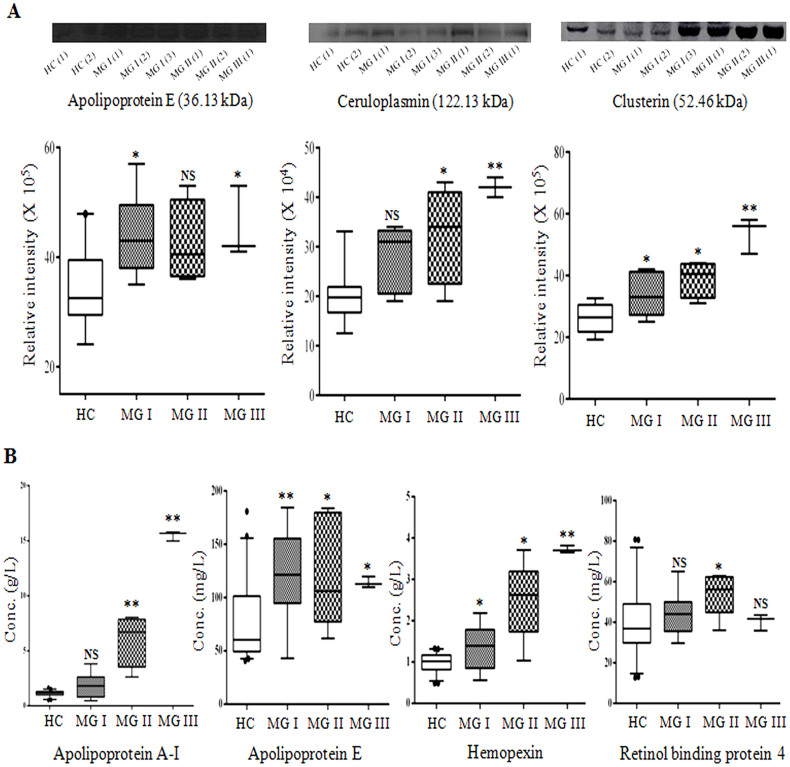
Immunoassay-based validation of selected differentially expressed proteins.(A) Western blot analysis of Apo E, CP, and CLU in serum samples of different grades of meningioma patients and healthy controls. (B) Estimation of serum levels of Apo A-I, Apo E, HPX, and RBP4 in HC (n = 45) and grade I (n = 14), grade II (n = 5) and grade III (n = 1) # meningioma patients by ELISA assay (# three technical replicates were analyzed). NS indicates p > 0.05; * indicates p < 0.05, ** indicates p < 0.005 in a Mann Whitney U-test.